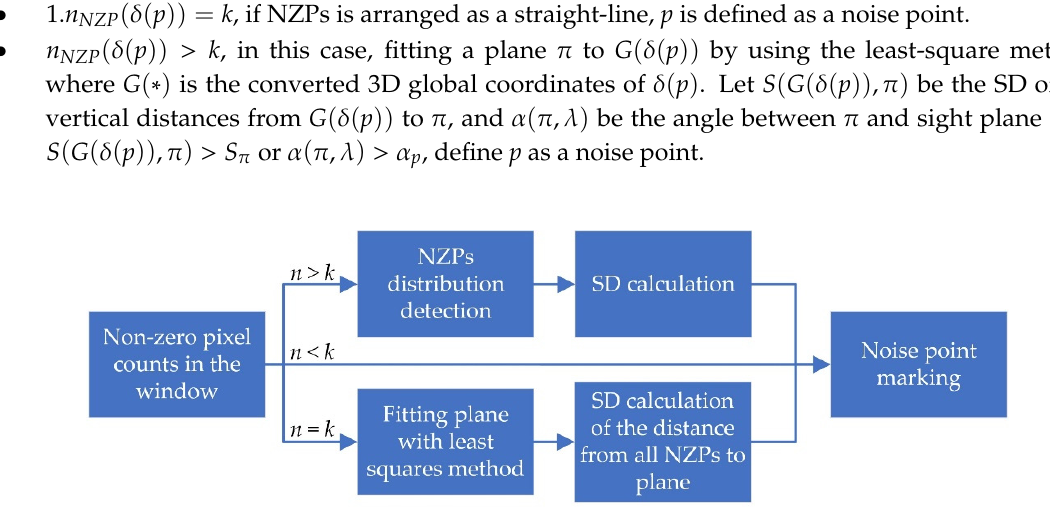
Figure 6. Edge noise filtering. Identification of this kind of noise points is mainly based on the relative position between non-zero points (NZPs).